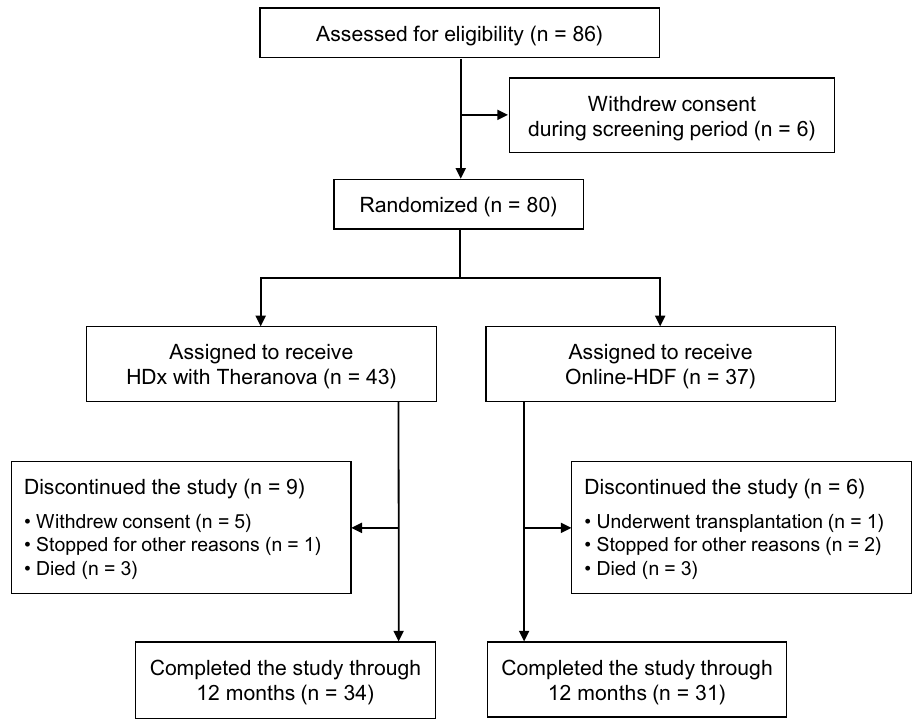
Figure 1. Flow chart of study patients. HDx expanded hemodialysis, HDF hemodiafiltration.